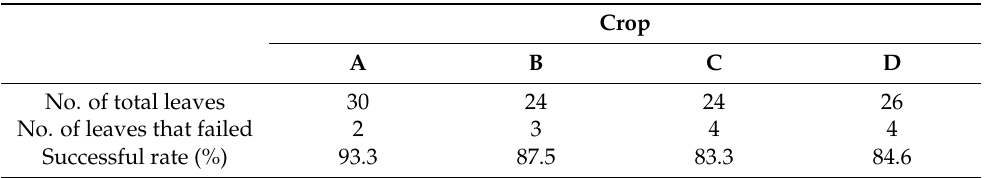
Table 2. Comparison of the number of leaves used in the experiment and the number of leaves that failed to